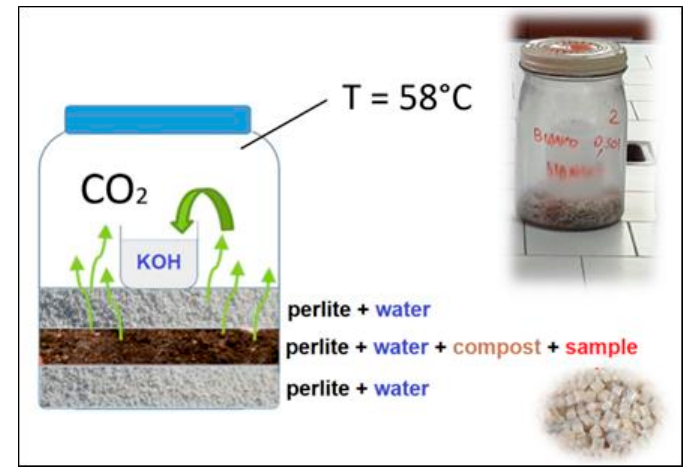
Figure 7. Scheme and photo of the apparatus used for the mineralization test.